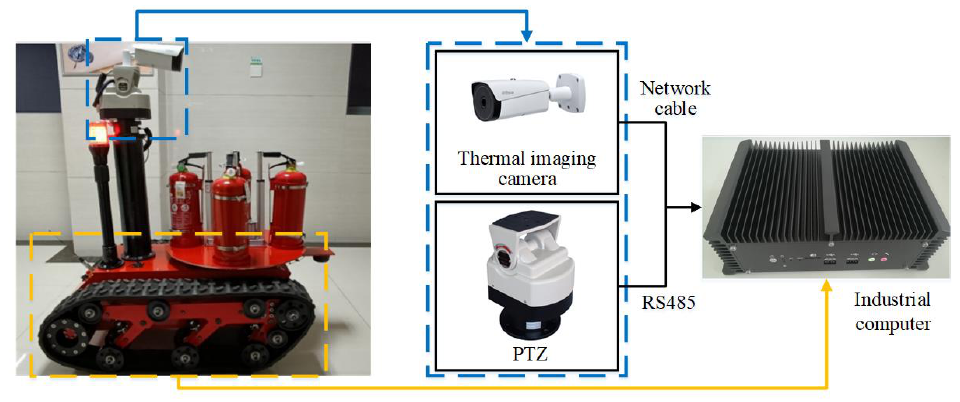
Figure 10. Video surveillance system.